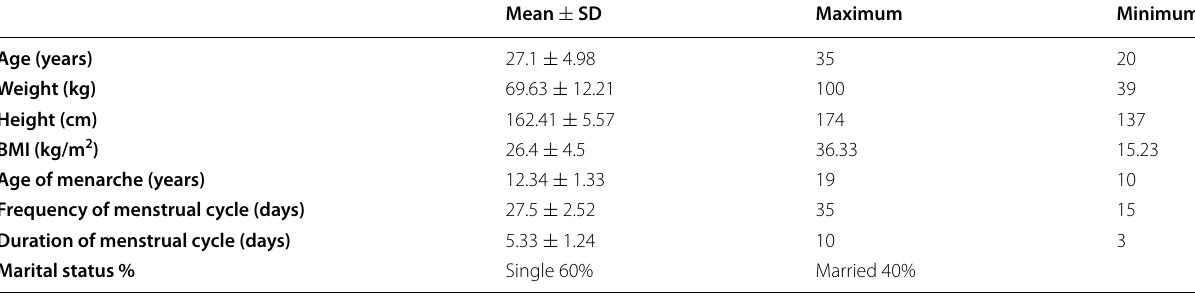
Table 1 Demographic characteristics of study participants